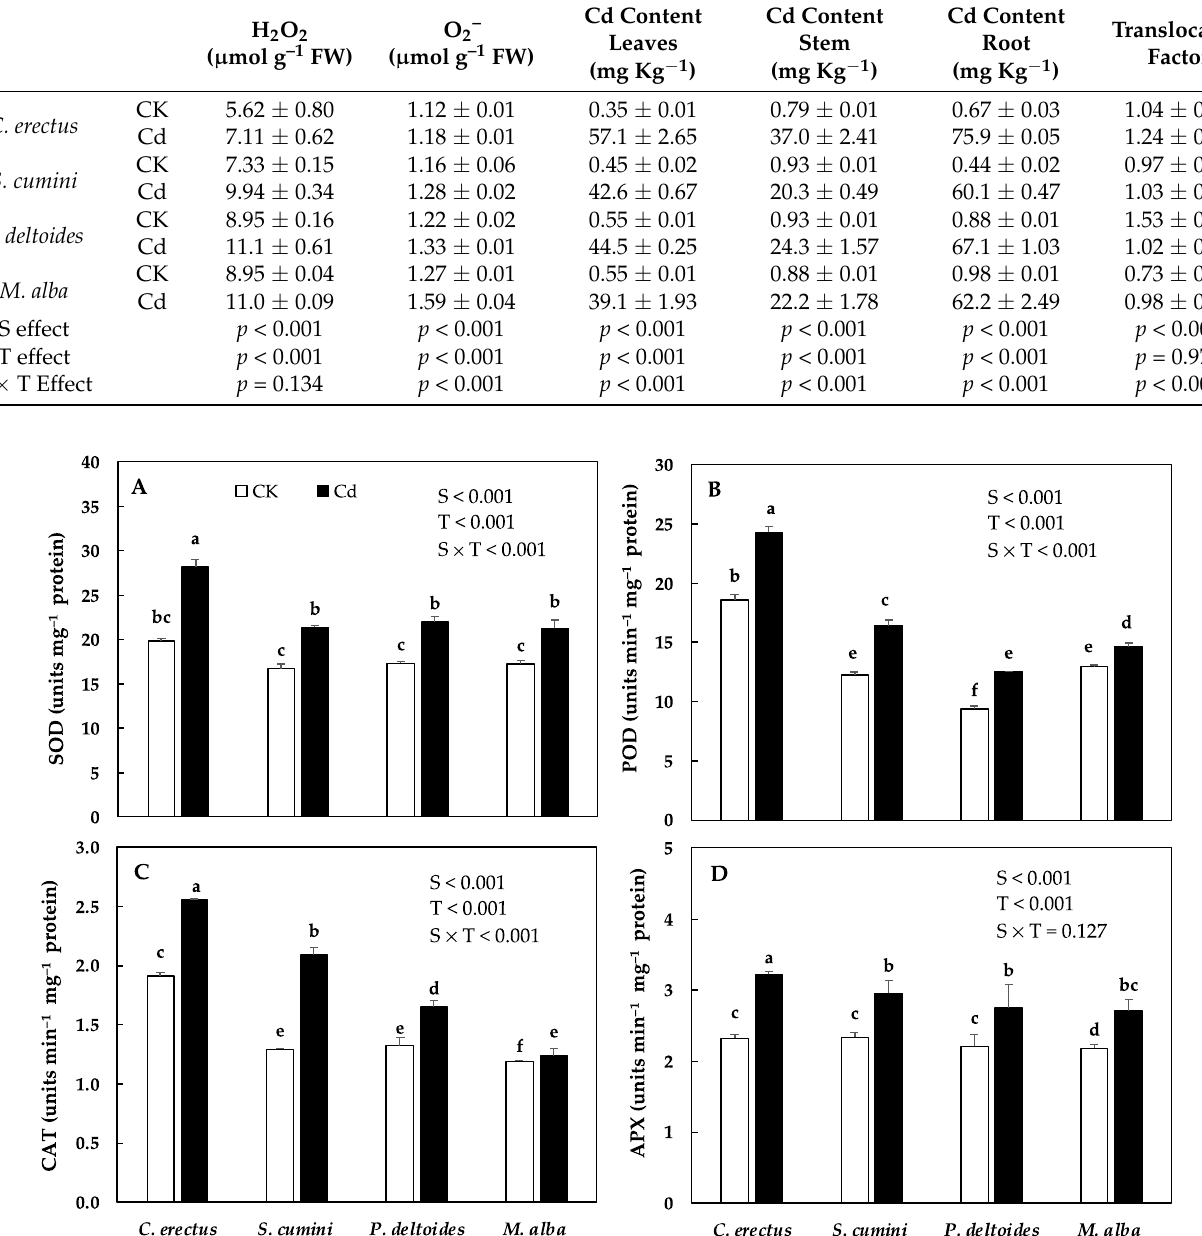
Table 2. Means ± SE for oxidants, Cd content in the leaves, stem and root and the translocation factor in four tree species under CK and Cd treatments. Small letters depict significant differences between treatment means (n = 5).